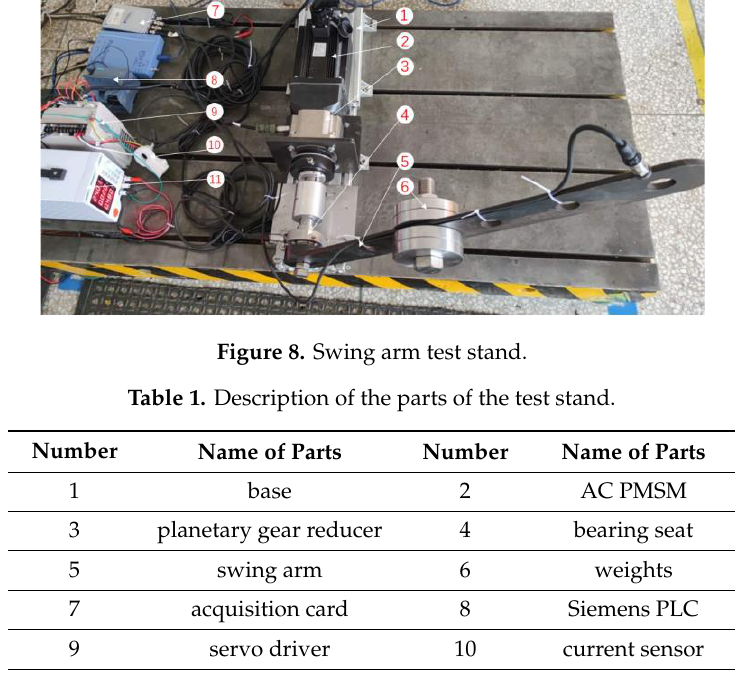
Figure 9. Ten cycle current signal.